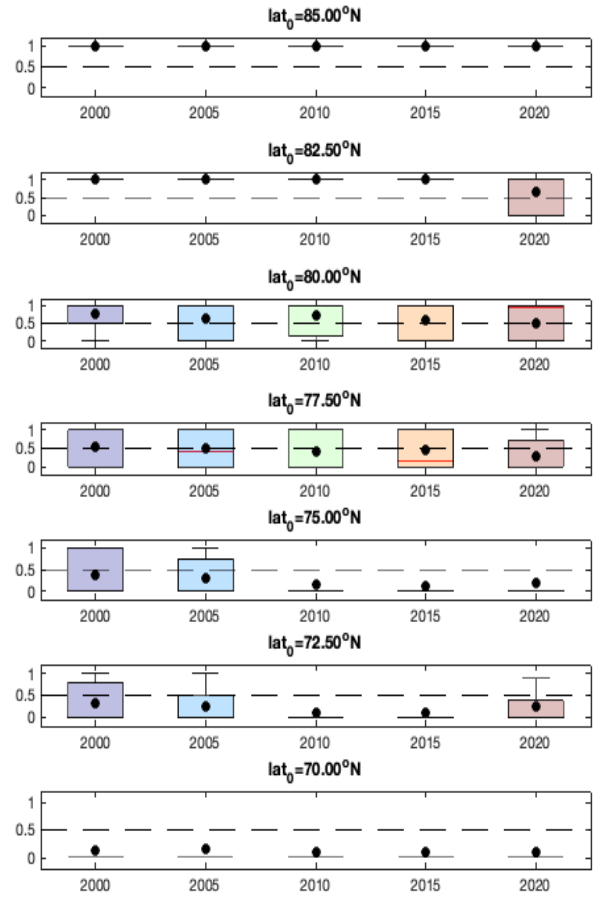
Figure 2. Boxplots of ice proportions in different latitude bands centered at lat 0 = 70 ◦ N, 72.5 ◦ N,..., 85 ◦ N. The average of ice proportions is represented by a dot ( • ) and the horizontal bars in the boxplots show the five-number summaries of a distribution (namely, minimum, first quartile, median, third quartile, and maximum). The five-year-interval boxplots are shaded from blue (2000) through green (2010) to red